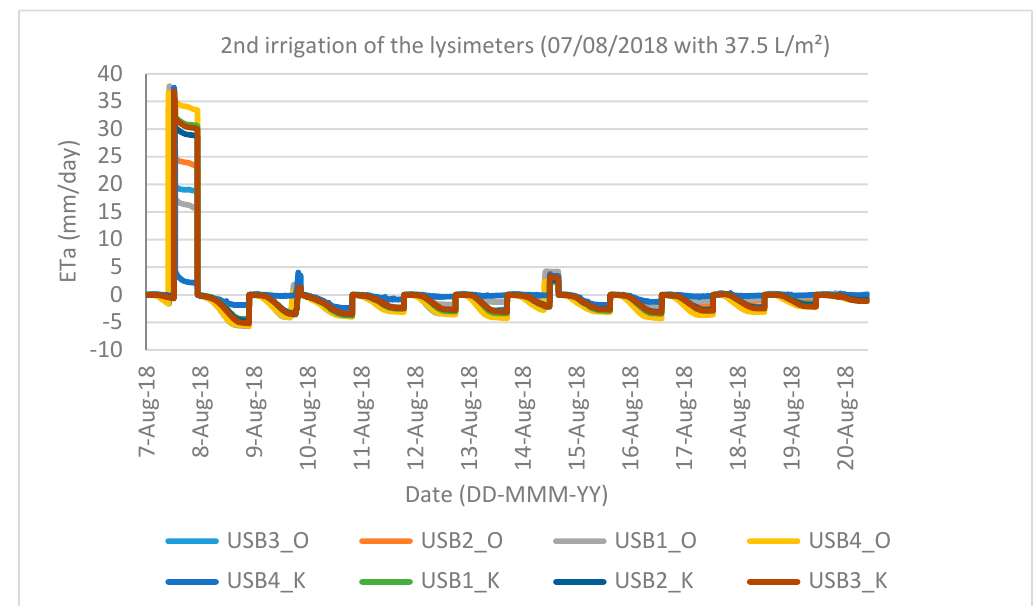
Figure 7. Decrease in the ET a after the second irrigation on 7 August 2018. All systems except USB4_K were fully saturated.